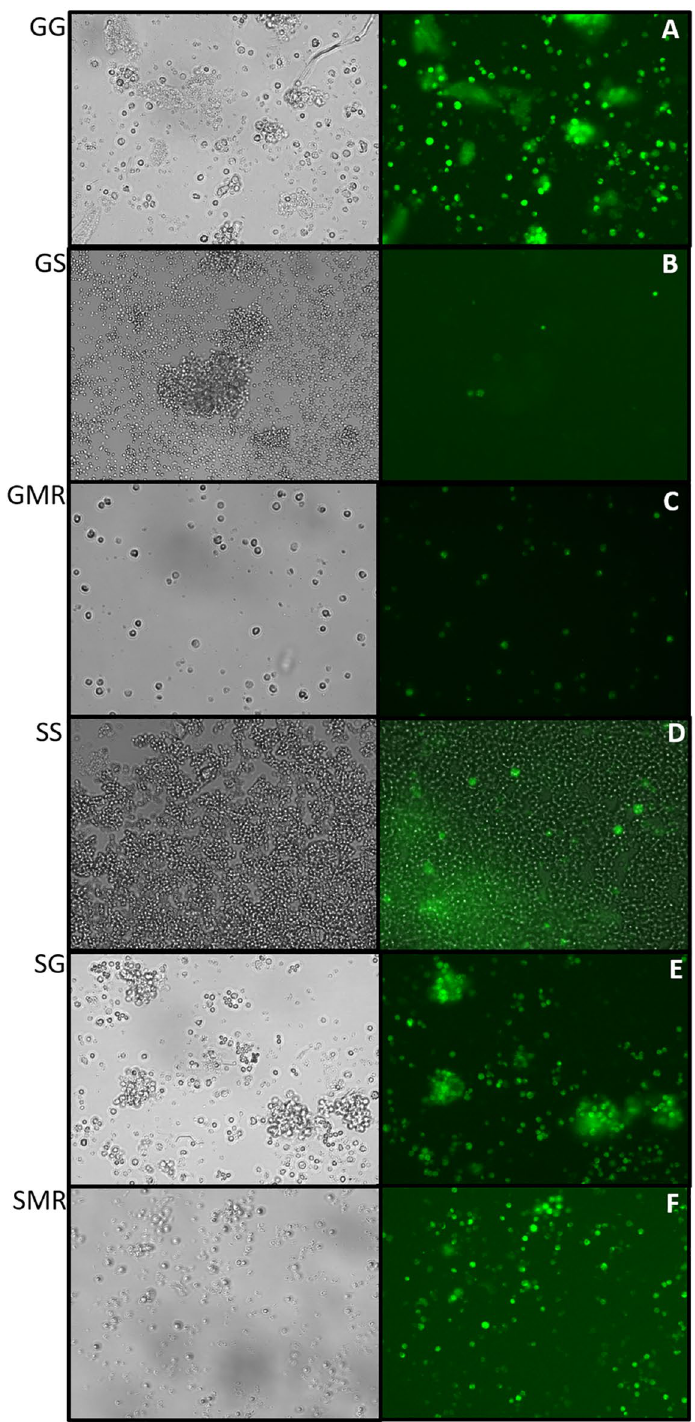
Figure 6. Analysis of CFSE-based lymphocyte proliferation. Thymus cells were stained with CFSE (1 × 10 6 / mL) and cultured in duplicate. The cells were incubated in a medium alone (nonstimulated-control) and with Concanavalin A (5 µg/mL, stimulated cells). The cells from piglet groups were cultured for 96 h. Cells were imaged on an EVOS M7000 microscope at 40X magnification; the same laser and gain settings were used to capture images at each point: ( A ) GG group, ( B ) GS group, ( C ) GMR group, ( D ) SS group, ( E ) SG group, and ( F ) SMR group, all cells were stimulated with Concanavalin